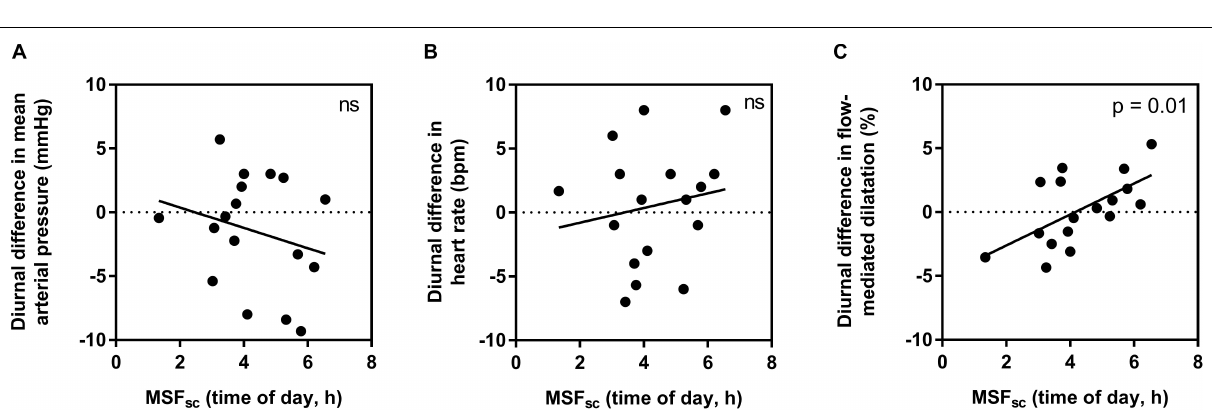
FIGURE 2 | The influence of chronotype (using corrected mid-sleep times on free day, MSF sc ) on individual diurnal differences in mean arterial pressure (A) , heart rate (B) , and flow-mediated dilatation (C) . Significance is shown in the top right corner (ns, not